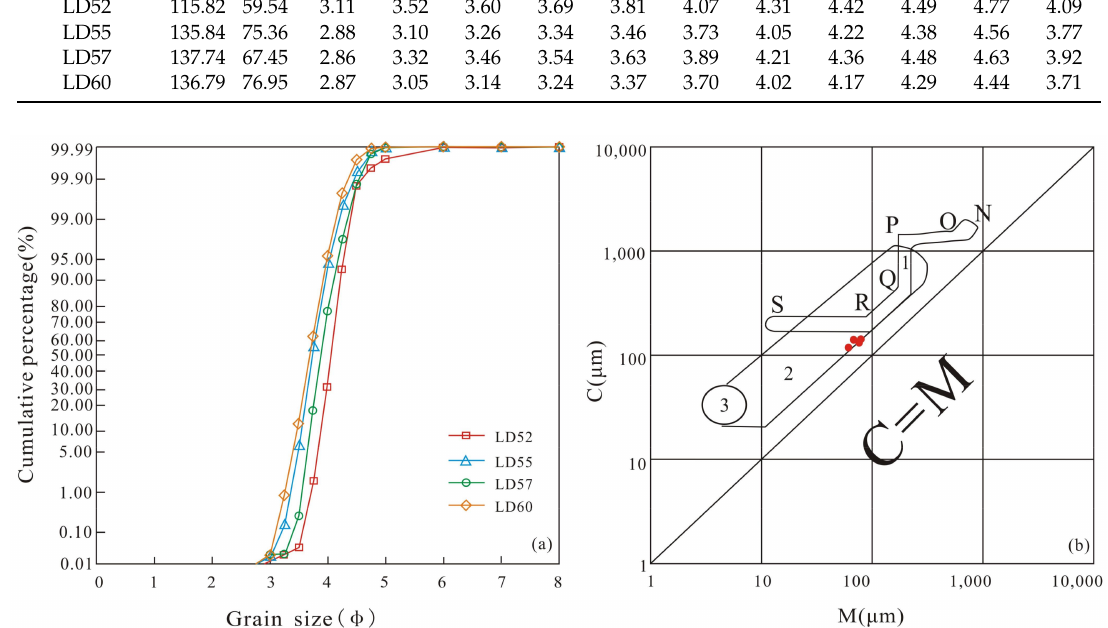
Figure 6. ( a ) Distribution of particle size parameters and ( b ) C-M pattern diagrams of sandstone samples. 1, Tractive current; 2, Turbidite; 3, Water suspension. N-O, Rolling grains; O-P, Rolling transport; P-Q, Suspension; Q-R, Graded suspension; R-S, Homogeneous suspension (the base map is from Passega